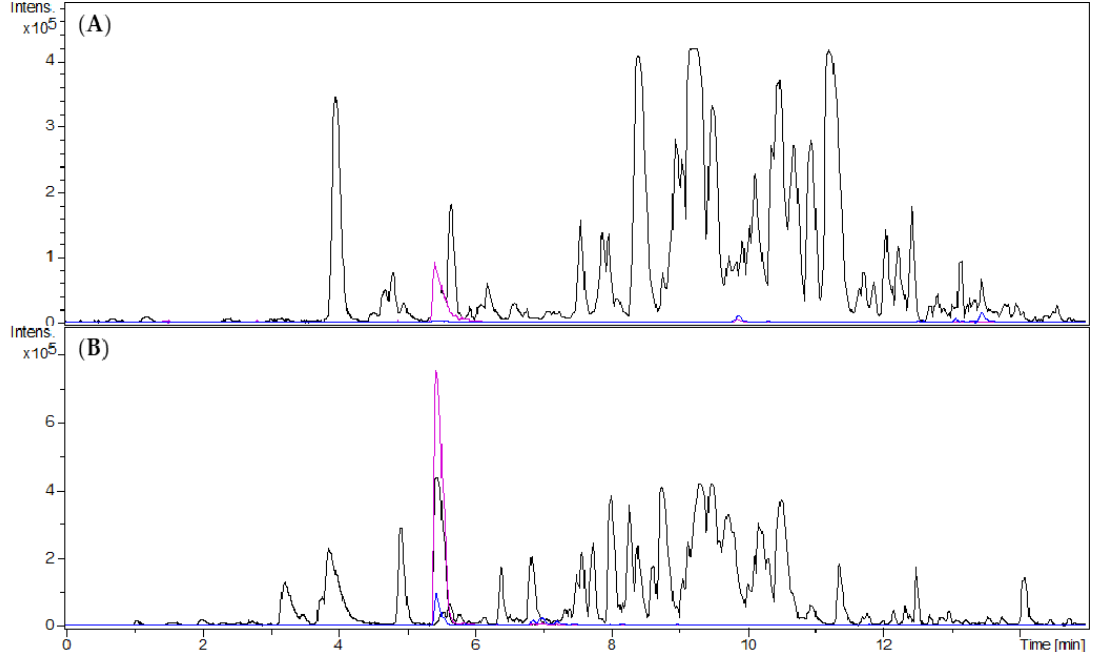
Figure 1. UHPLC/+ESI-QqTOF-MS chromatograms: Base peak chromatogram of m/z 200–1000 (black), Extracted ion chromatogram of m/z 249 [M + 2H] 2+ (pink), Extracted ion chromatogram of m/z 497 [M + H] + (blue); ( A ) dichloromethane extract (GBUS); ( B ) alkaloid fraction (ALOF). The target compound was enriched from GBUS to ALOF by factor 19.